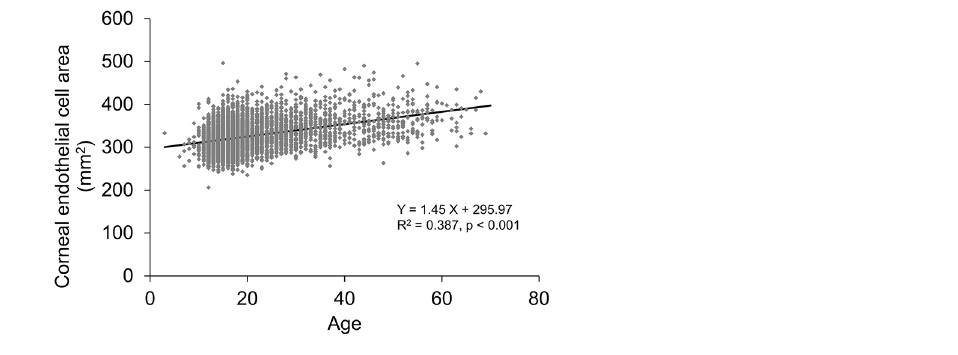
Figure 4. Association between corneal endothelial cell area and age in ophthalmologically healthy Japanese. Based on the linear regression model, a significant mild positive association between corneal endothelial cell area and age was observed (Y = 1.45 X + 295.97, R 2 = 0.387, p <